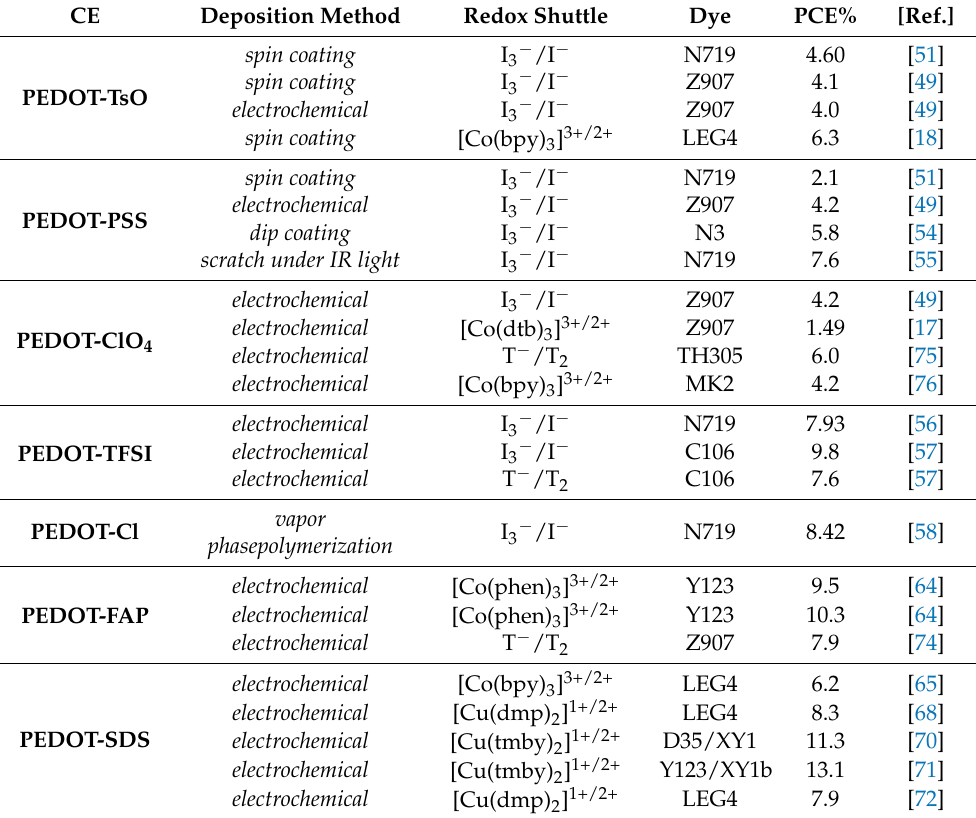
Table 1. Photovoltaic parameters of PEDOT-based DSSCs with various redox mediators and dyes under AM1.5 G